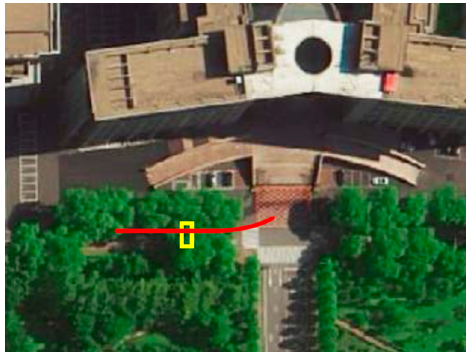
Figure 16. The real scene of outdoor experiment location. The red line represents the driving route of our vehicle and the yellow rectangle is the place of the deceleration zone.